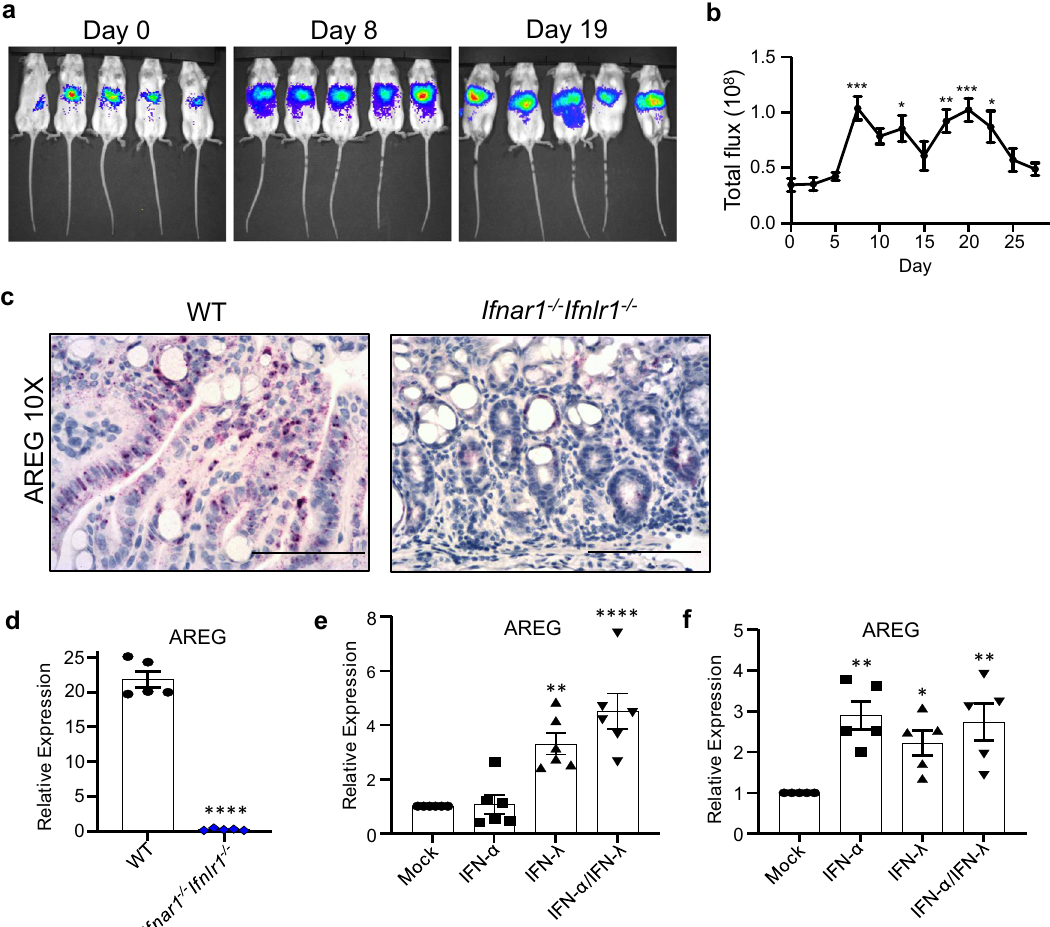
Fig. 6 Ifnar1 − / − Ifnlr1 − / − mice have diminished AREG expression following DSS treatment and IFNs regulate AREG expression. a, b Mx2-Luciferase reporter mice ( n = 5) were exposed to 1.5% DSS in drinking water for 7 days, followed by regular water. Mice were injected with luciferin and levels of IFN- controlled Mx2 promoter-driven luciferase expression were measured by IVIS on selected days. c, d 6 – 8-week-old WT and Ifnar1 − / − Ifnlr1 − / − mice were administered 1.5% DSS in drinking water for 7 days, followed by regular water. Levels of colonic AREG transcripts were analyzed on day 11 by c in situ hybridization ( n = 5) and d qPCR from total colon homogenates ( n = 5). e Murine intestinal epithelial cells (mIECs) or f fl uorescent-activated cell (FAC)- sorted bone marrow-derived CD45 + cells were treated with IFN for 30 min and upregulation of AREG transcripts were analyzed by qPCR ( e , n = 6; f , n = 5). Scale bars are 100 μ M. Data are representative of two ( a, b ) or three independent experiments ( c ) or pooled from two independent experiments ( d – f ). Symbols represent individual data points ( d – f ). Quantitative data were analyzed using b, e, f one-way ANOVA or d two-tailed unpaired t -test followed by Tukey ’ s ( b ) or Bonferroni ’ s multiple comparisons test ( e, f ) and represent mean values with SEM. b * P = 0.0231 (day 13), * P = 0.0168 (day 22), ** P = 0.0055 (day 18), *** P = 0.0004 (day 8), *** P = 0.0005 (day 19); P values are for the indicated day compared with day 0. d **** P ≤ 0.0001 and is for the indicated animal group compared with control group of WT mice. e ** P = 0.0027, **** P ≤ 0.0001. f * P = 0.0483 (IFN- λ ), ** P = 0.0023 (IFN- α ), ** P = 0.005 (IFN- α /IFN- λ ). P values are for the indicated treatment compared with mock ( e, f